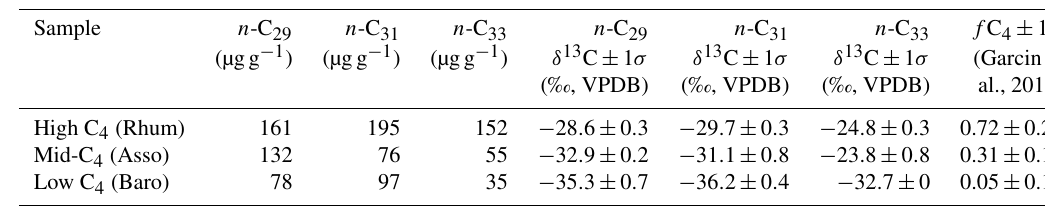
Table 2. Lake surface sediment samples used in case study 2, with measured chain-specific n -alkane concentrations and δ 13 C values; these data were originally published by Garcin et al. (2014).